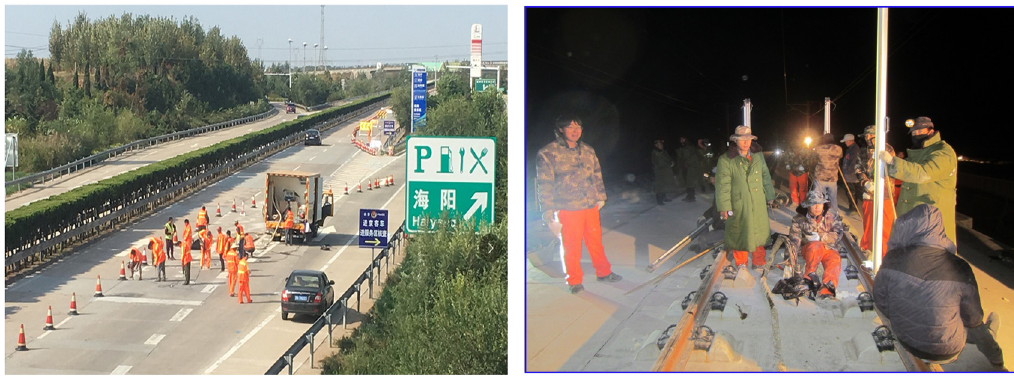
Figure 1: Engineering application of nonwater reacted polyurethane